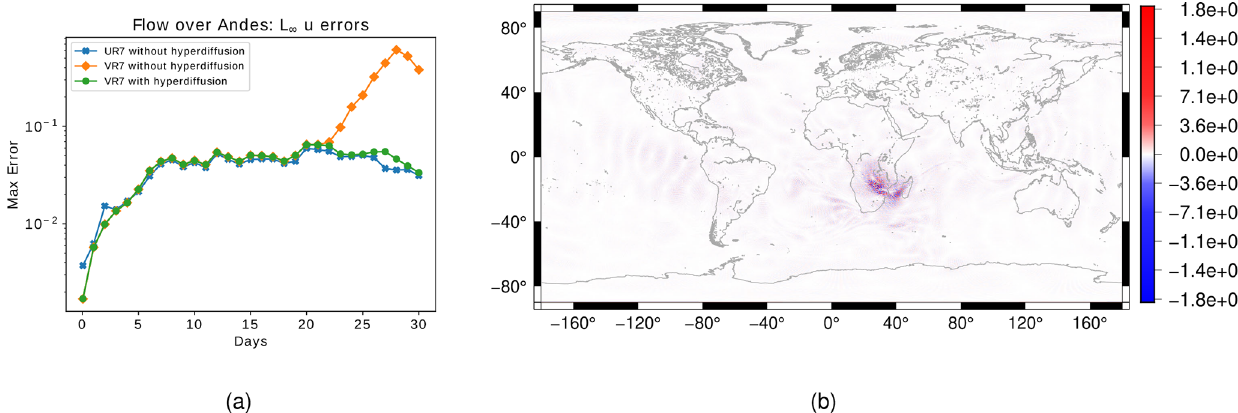
Figure 13. Flow over the Andes test case for the shallow-water model: (a) time evolution of relative error in the L ∞ norm for the normal component of the velocity field for the UR7 grid (blue line) and for the VR7 with (green line) and without (orange line) numerical fourth- order hyperdiffusion based on the alignment index. (b) Cell-wise error for the normal component of the velocity field at day 30 for the VR7 grid without fourth-order hyperdiffusion. We consider the ENDGame solution as a reference